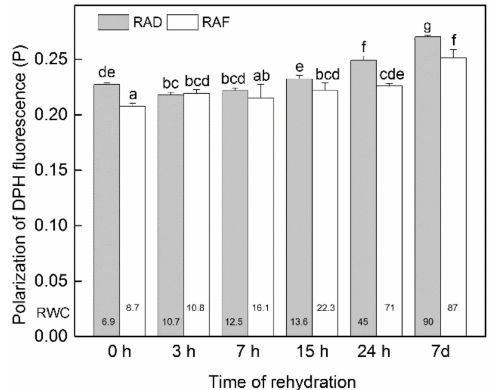
Figure 7. Changes in the fluidity of thylakoid membranes isolated from H. rhodopensis under recovery from drought- (RAD) and freezing-induced desiccation (RAF). Values are given as mean ± SE. Changes between RAD and RAF were statistically compared. The same letters within a graph indicate no significant differences assessed by the Fisher LSD test ( p ≤ 0.05) after performing ANOVA. The RWC of plants at each time point, presented in %, are shown at the bottom of the